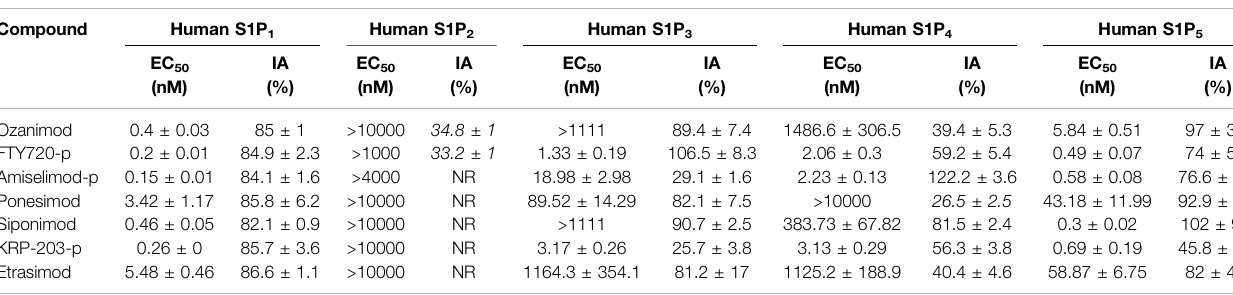
TABLE 2 | [ 35 S]-GTP γ S binding potencies for human S1P 1 – S1P 5 .